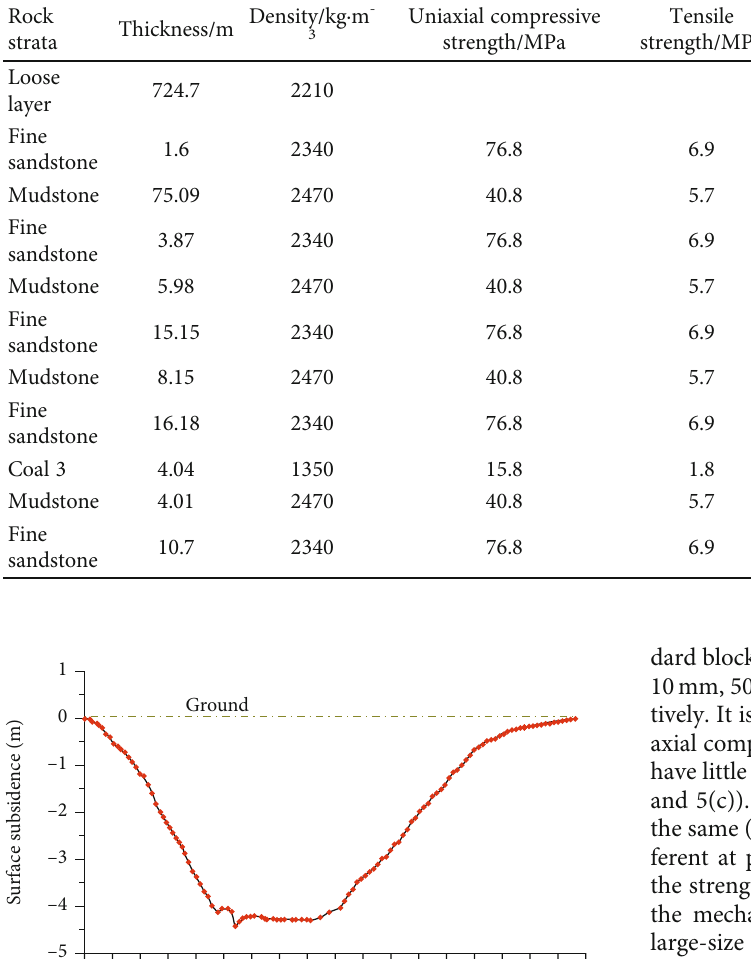
Table 1: Parameters of strata.